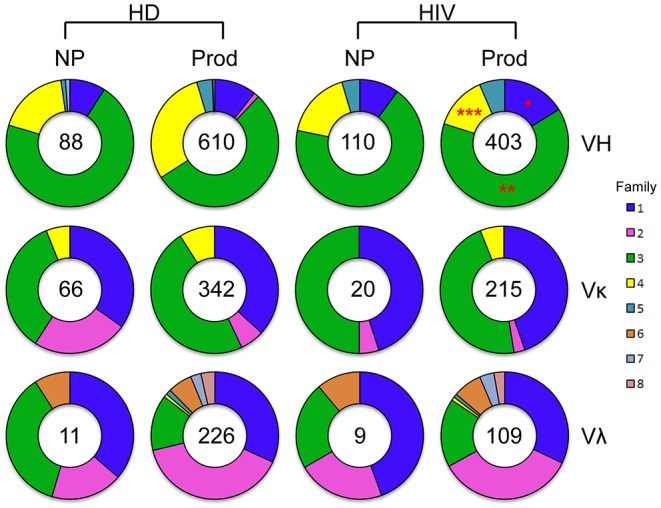
VH-, Vκ-, and Vλ-family distribution of RT-PCR–amplified sorted plasmablasts analyzed with ImMunoGeneTics information system (IMGT)/V-Quest. Families are color-coded. The size of the colored area corresponds to the percent out of the total number of sequences, as is indicated in the center of the pie graphs. Differences in the gene family distributions were evaluated between productive repertoires of healthy donors (HDs) and HIV-infected donors (HIVDs) by chi-square test. A significant difference was considered when two-sided p-value < 0.05. *p < 0.05; **p < 0.01; ***p < 0.0001.